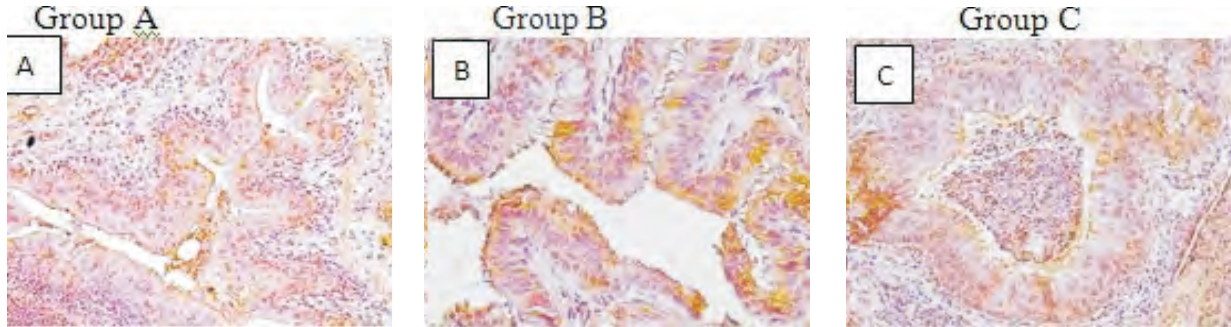
Figure-2. A. M. multocida antigens demonstrated by the red chromogen in the cytoplasm of alveolar macrophages, exudates around the bronchioles and in blood vessels B: in exudates in bronchioles and on the bronchiolar epithelium and C: in exudates in bronchioles and on